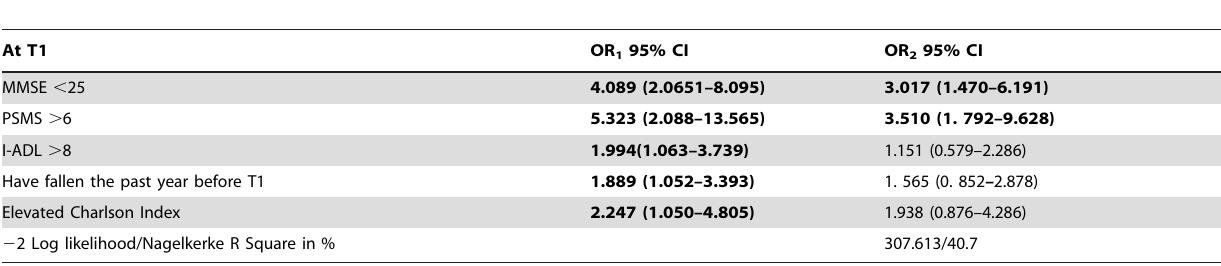
Table 3. Associations with nursing home admission versus not within the follow-up year (N =463).